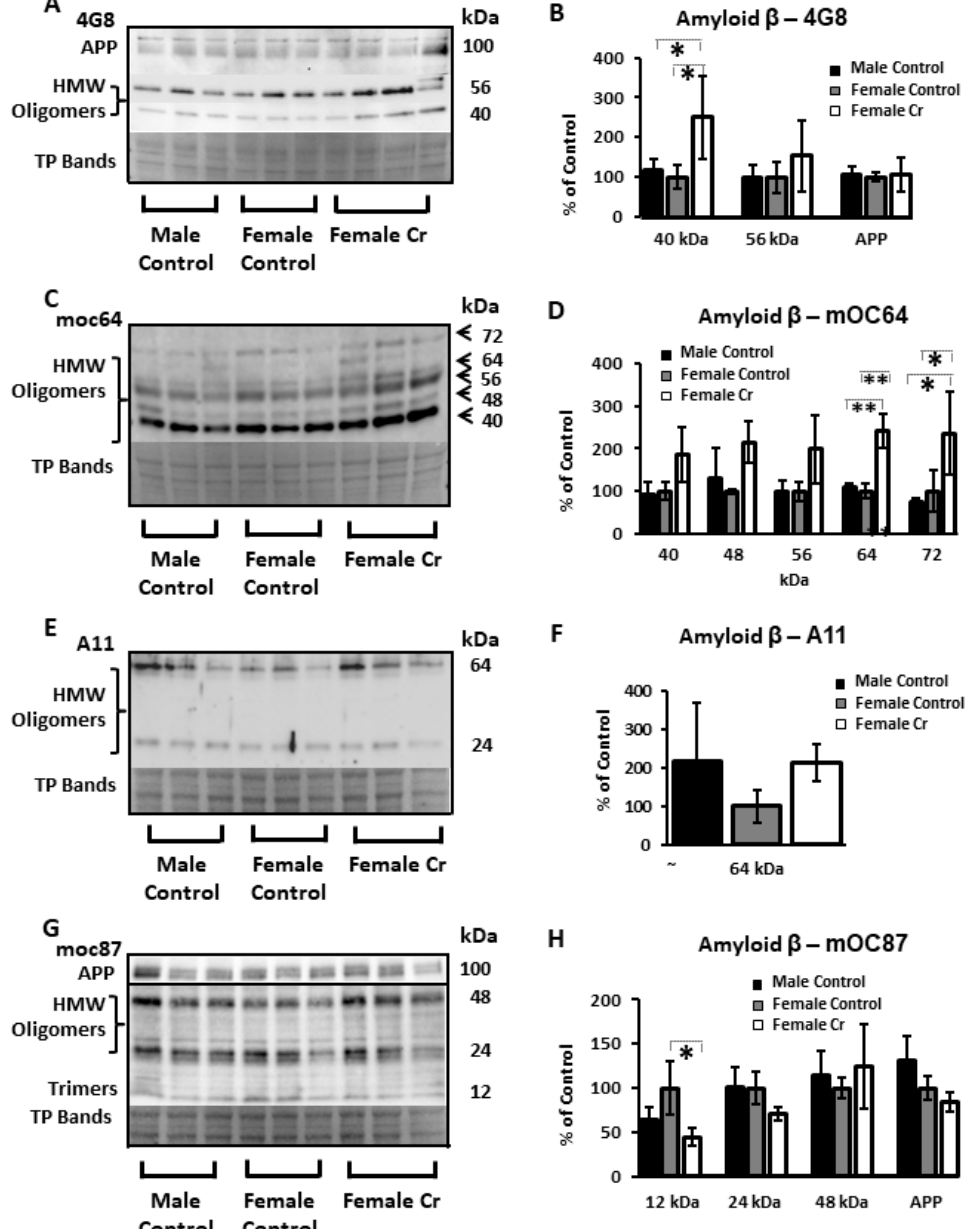
Figure 10. Relative hippocampal levels of amyloid β (A β ) and amyloid precursor protein (APP) in control and Cr-supplemented 3xTg mice. Representative Western blots detecting A β (and APP in some cases) with the antibodies ( A ) 4G8, ( C ) moc64, ( E ) A11, and ( G ) moc87. Total protein (TP) was measured with Ponceau S staining (representative bands shown to indicate sample loading). Bar graphs ( B , D , F , H ) depict densitometry values after normalization to total protein bands and expressed as the percentage change from female control-fed means (100%) ± SD. ANOVA or Kruskal–Wallis; n = 3–4. * p < 0.05; ** p < 0.01. With respect to ptau, the levels were not affected by Cr supplementation in females (when normalized to total tau or total protein). However, sex differences were detected (with LSD post hoc